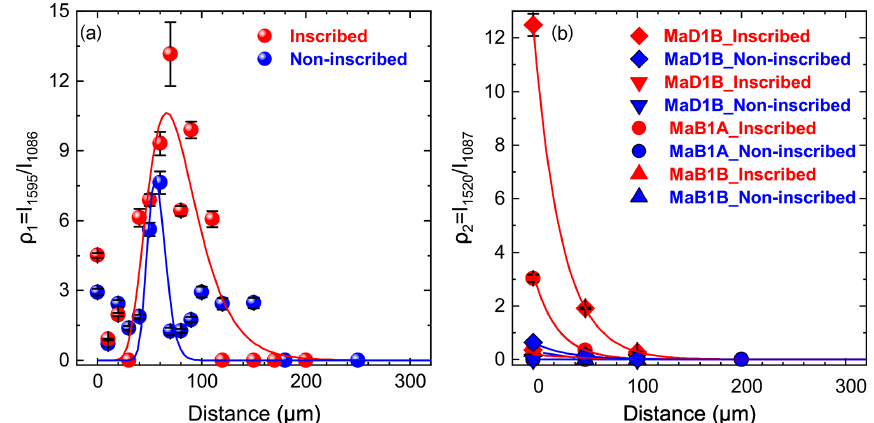
Figure 8. Intensity ratios of I 1595 / 1086 (a) and I 1520 / 1087 (b) plotted against the distance to the surface measured along the lines inferred in the legend beneath inscribed and non-inscribed regions of samples from Asia Minor (a) and Hamburg (b) . Lines in (a) are lognormal fits, whereas lines in (b) are exponential decay fits to the corresponding data